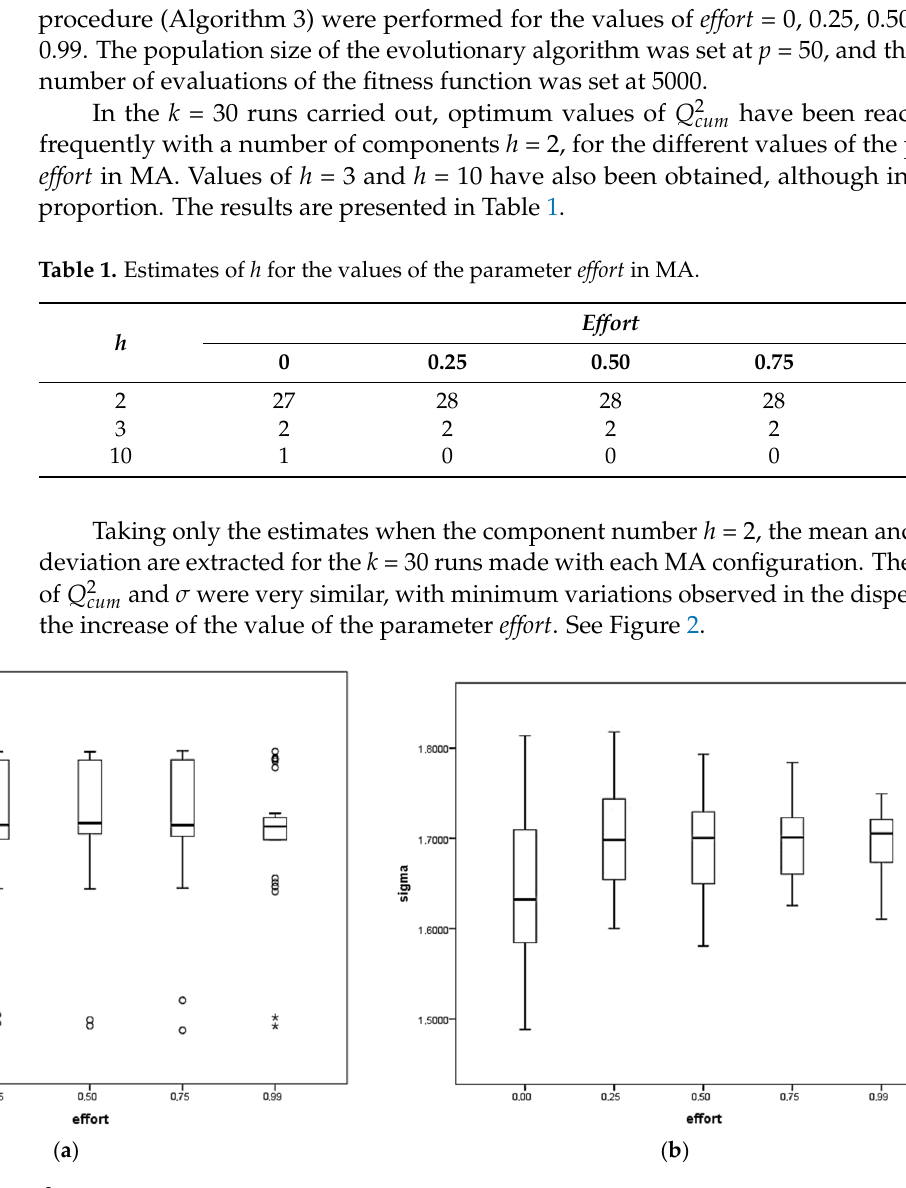
Table 2. Mean and standard deviation of (cid:1843) (cid:3030)(cid:3048)(cid:3040)(cid:2870) , (cid:2026) and running time estimates. Algorithm